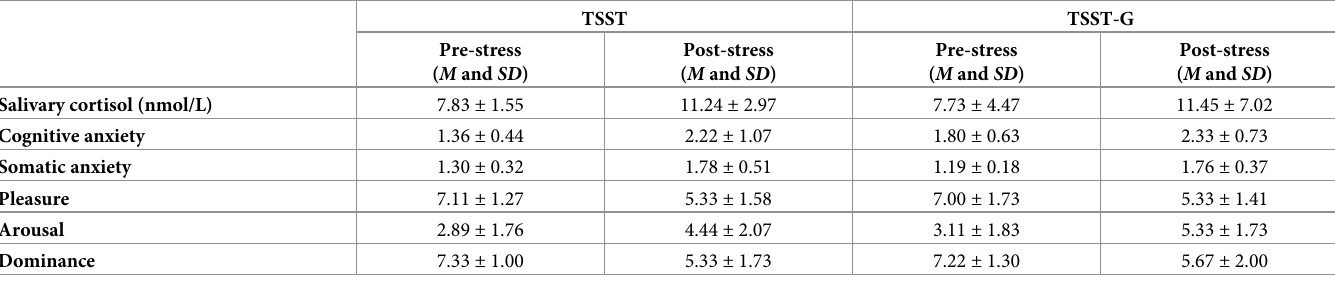
Table 1. Descriptive statistics of physiological and psychological